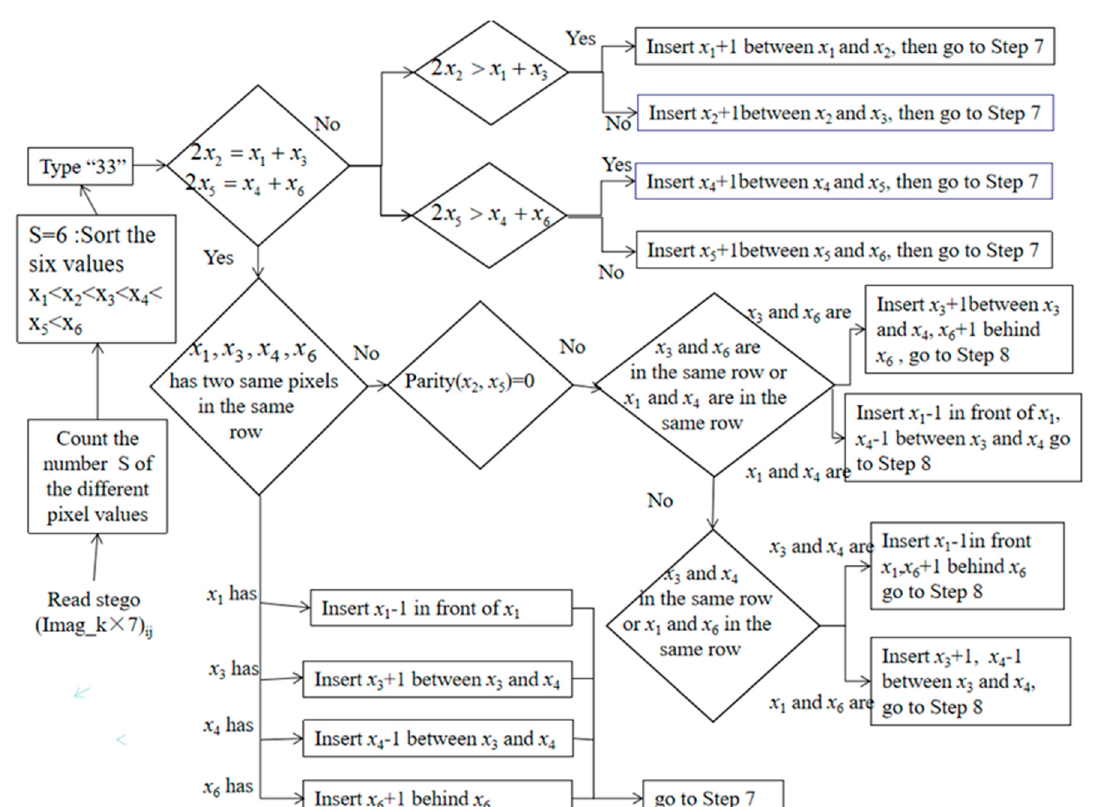
Figure 7. Flowchart of extraction phase when S = 6. Type 33, Note: S indicates the number of different pixel values.